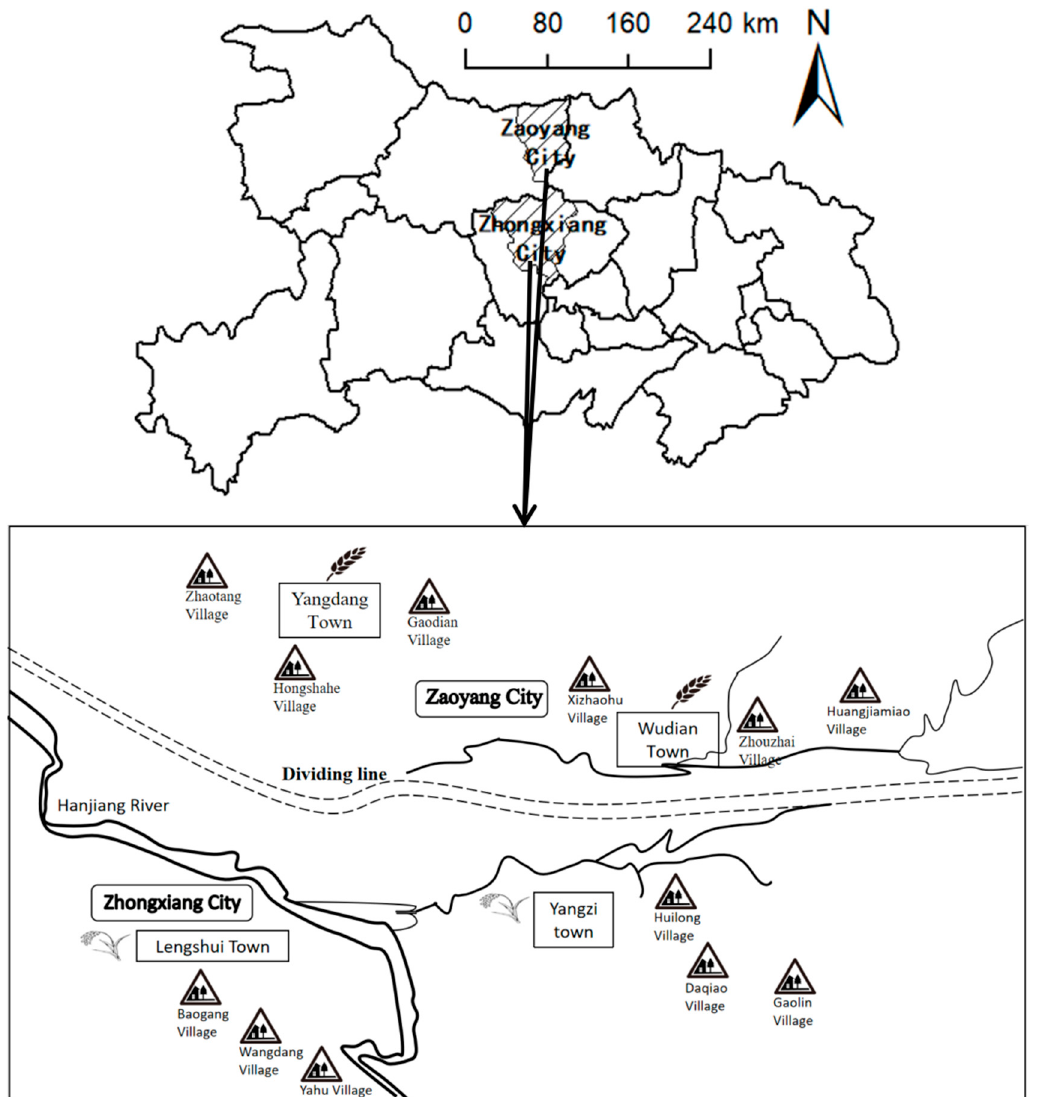
Figure 1. Sample area map.